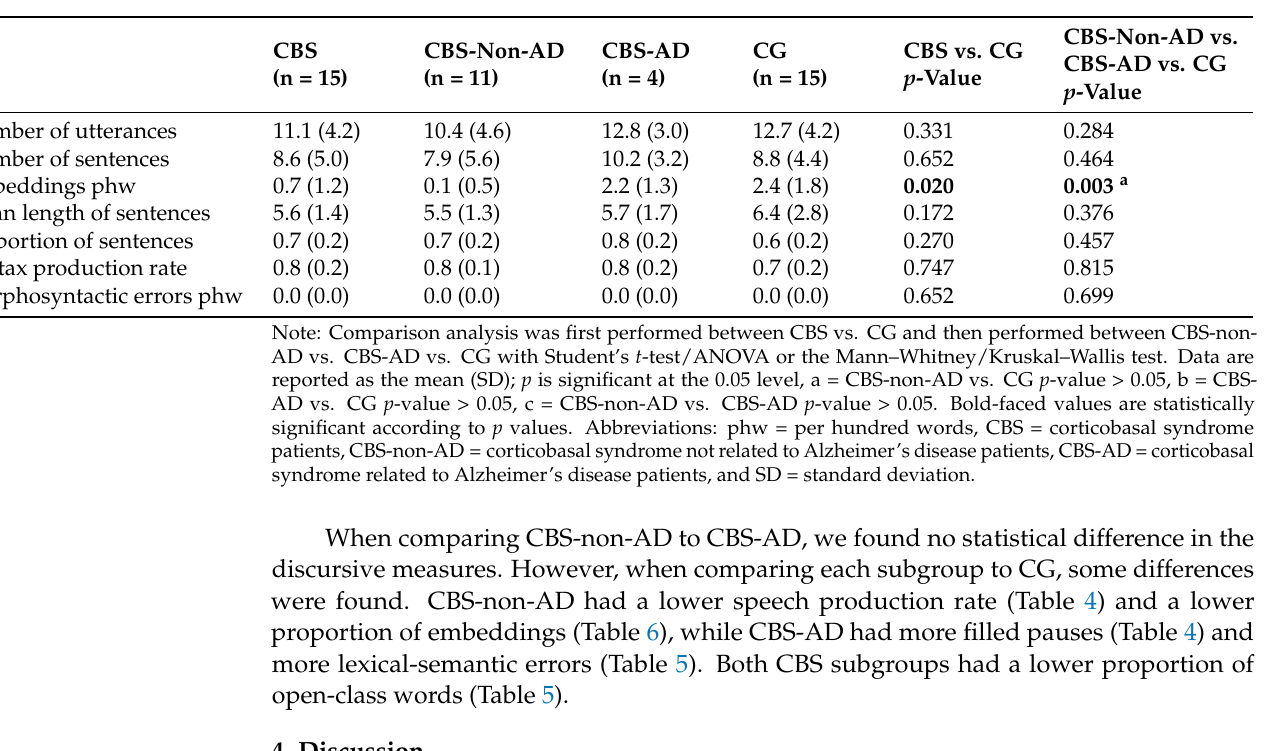
Table 6. Performance on discursive measures related to “syntactic structure and complexity” by diagnostic